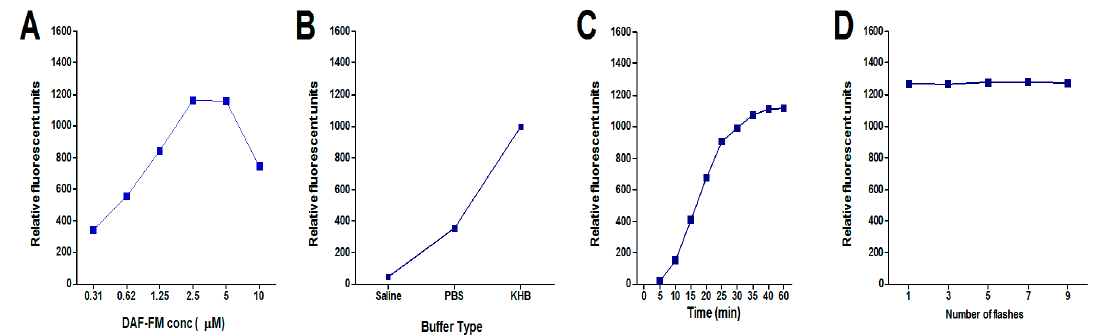
Figure 2. Effect of ( A ) different DAF-FM concentrations; ( B ) different buffer types; ( C ) incubation times; and ( D ) a different number of flashes on the fluorescence intensity of the reaction product of NO generated from 1 µM NO donor (SIN-1). Values shown represent the mean ± standard error of the mean (SEM) for three independent replicated experiments.